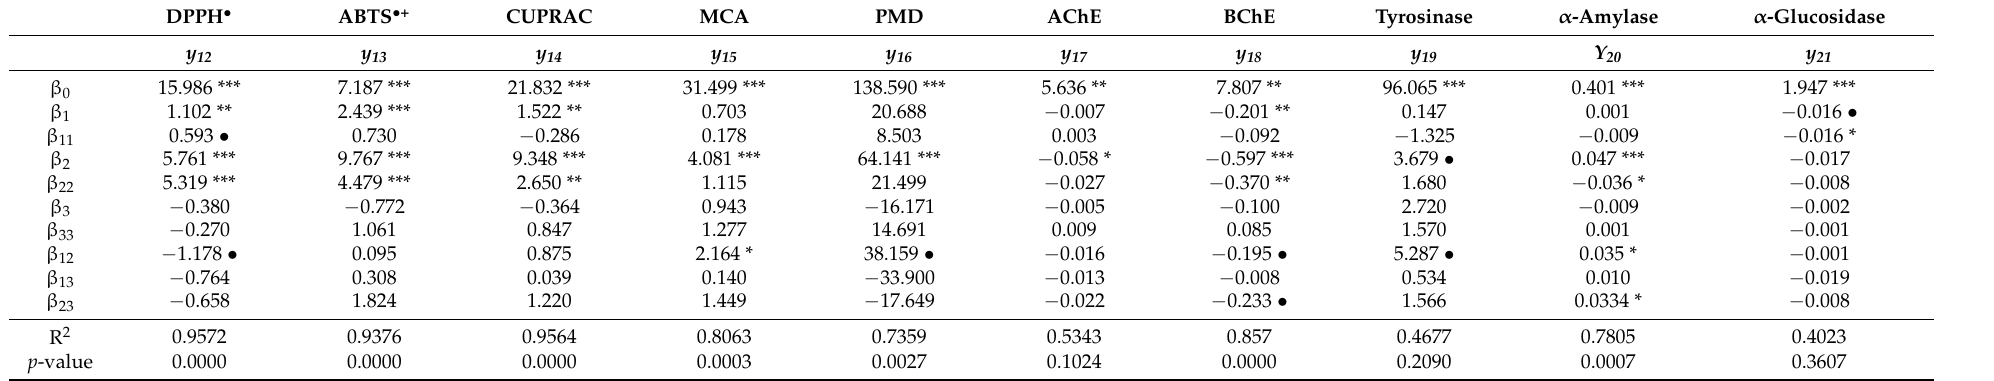
Table 4. Regression coefficients and statistical parameters that measure the correlation and significance of the